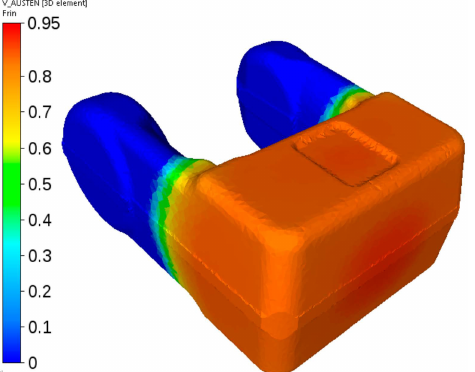
Figure 23. First stage of the cooling of the fork from steel C—calculated distribution of the austenite volume fraction after cooling to the temperature at which ferritic transformation is completed and pearlitic transformation has not begun